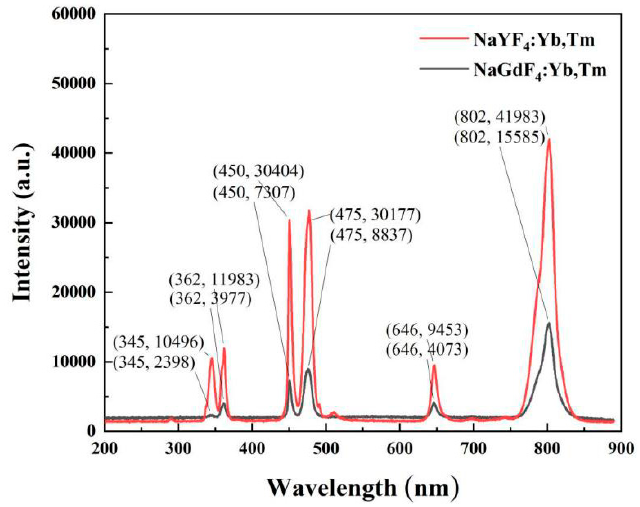
Figure 8. Comparison of fluorescence spectra of NaYF 4 : 20% Yb 3+ , 0.5% Tm 3+ and NaGdF 4 : 20% Yb 3+ , 0.5% Tm 3+ at 980 nm excitation.